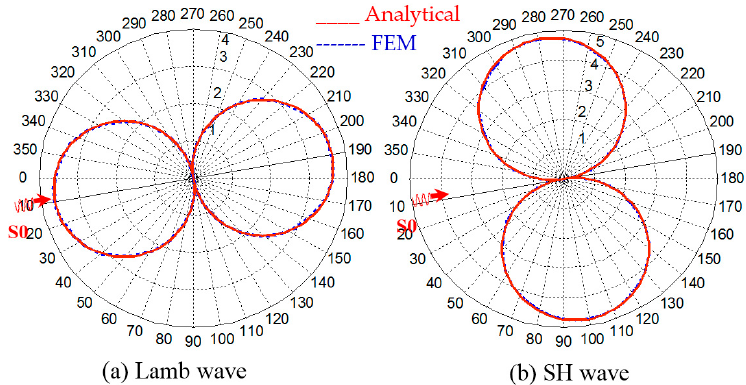
Figure 4. Comparison between analytical and FEM results ( a ) WDIC LW_LW ( b ) WDIC LW_SH in polar coordinates (pristine plate).